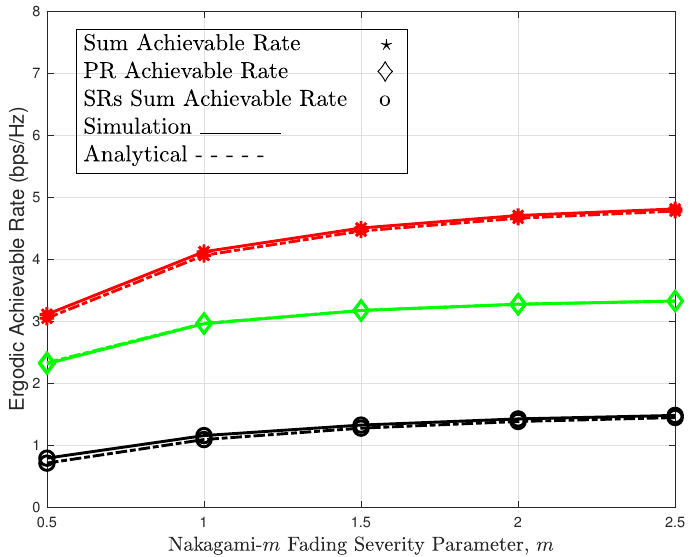
Figure 3. Ergodic achievable rate performance versus Nakagami-m fading severity